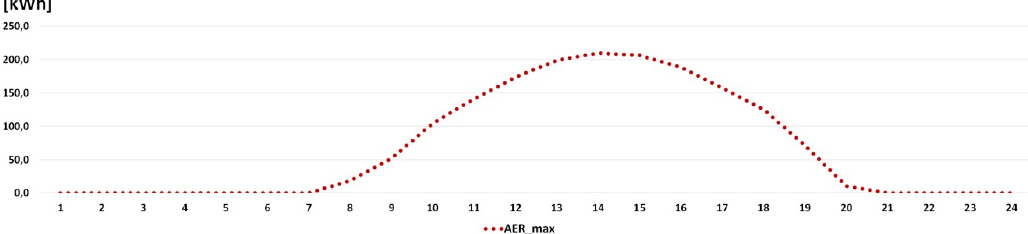
Figure 8. The maximum aggregated energy produced by the energy community for the most typical day of September.